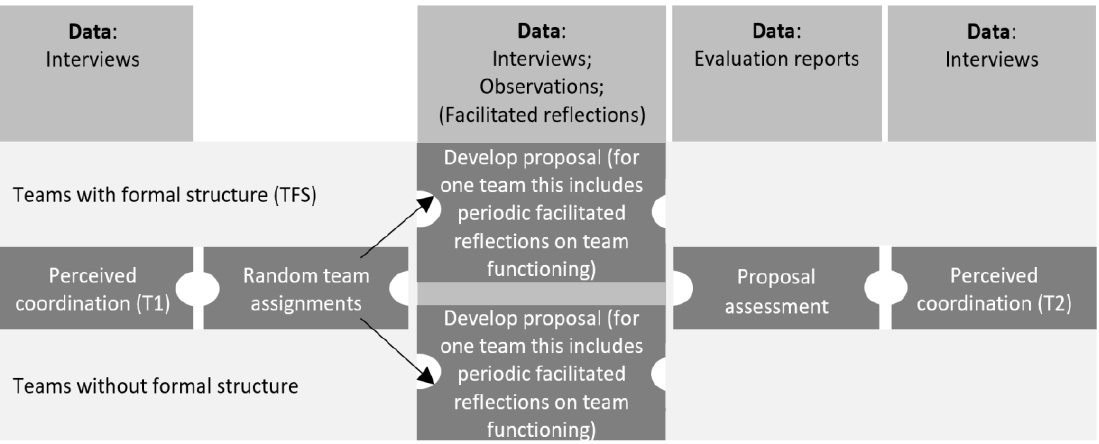
Figure 3. Overview of research strategy (source: authors).